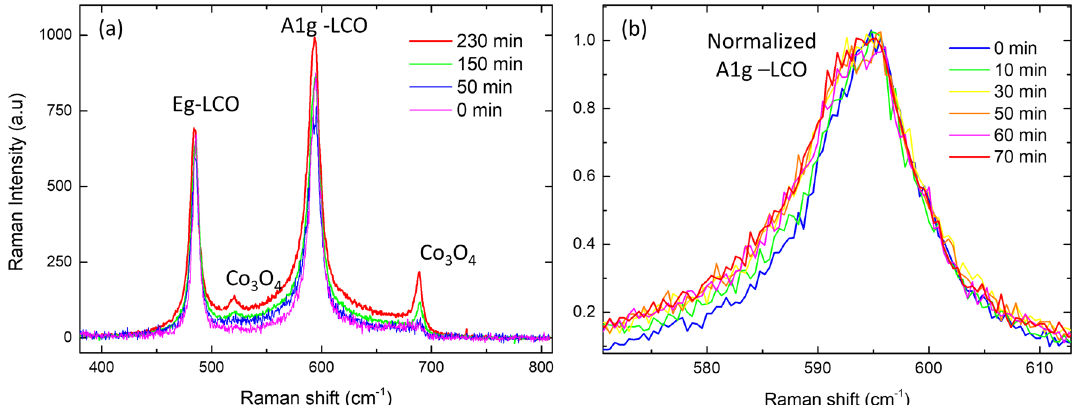
Figure 7. ( a ) Evolution of the Raman spectra for various exposure times at a 10 –2 M solution of oxalic acid. ( b ) Evolution of the A1g-LCO peak (normalized to the height) for exposure times up to 70 min (corresponding to Regime II). The broadening of the left side is due to the appearance of the hex-II phase of a broadening of both the Eg (485 cm −1 ) and the A1g (593 cm −1 ) peaks is observed at their low-energy side, as